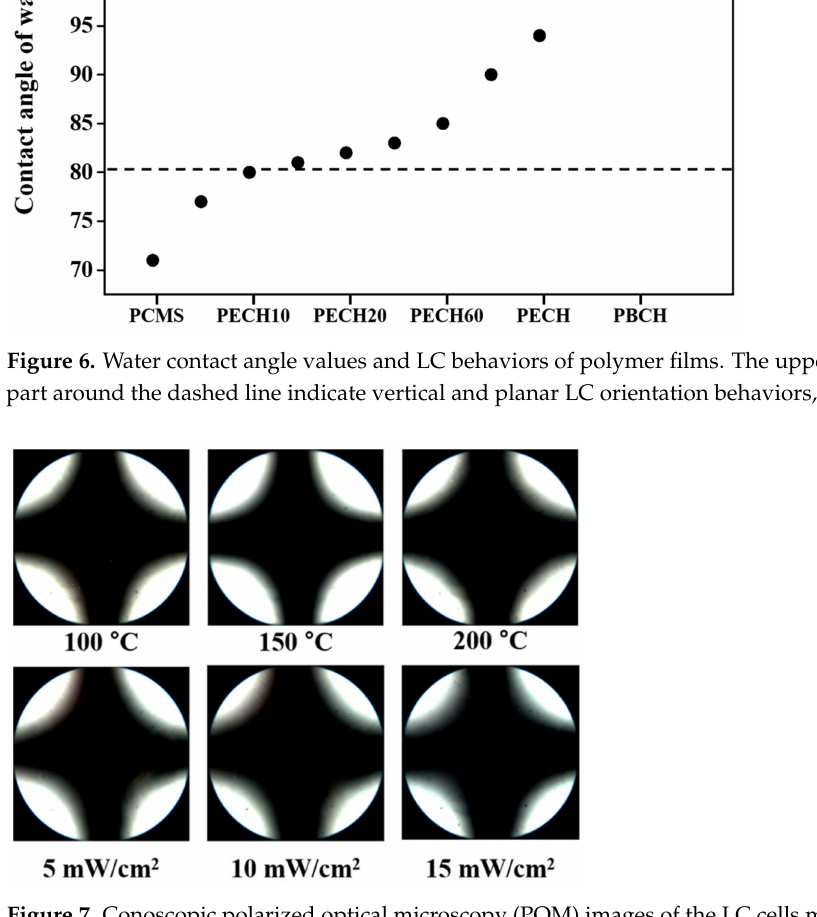
Figure 7. Conoscopic polarized optical microscopy (POM) images of the LC cells made using PECH films, after thermal treatment at 100, 150, and 200 ◦ C for 10 min and UV treatment having intensities of 5, 10, and 15 mW/cm 2 for 30 min,